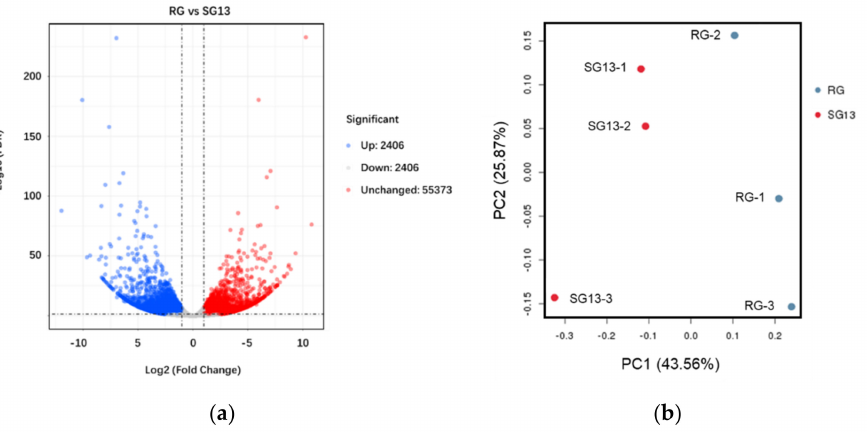
Figure 1. Difference in the expression patterns of two T. hemsleyanum ecotypes. ( a ) Volcano plot of differentially regulated genes in RG vs. SG13. The red dots were expressed more in SG13 and blue dots were expressed more in RG. ( b ) 2D PCA score plot of RG vs.